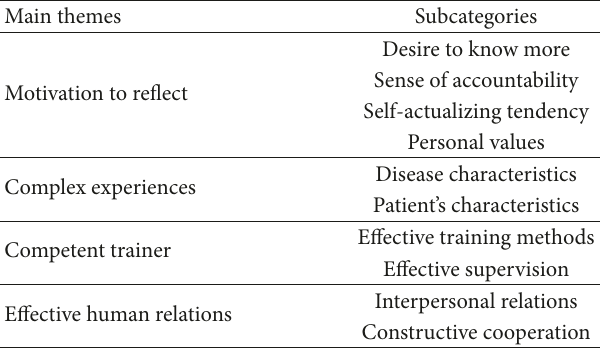
Table 1: A list of main themes and subcategories extracted from the